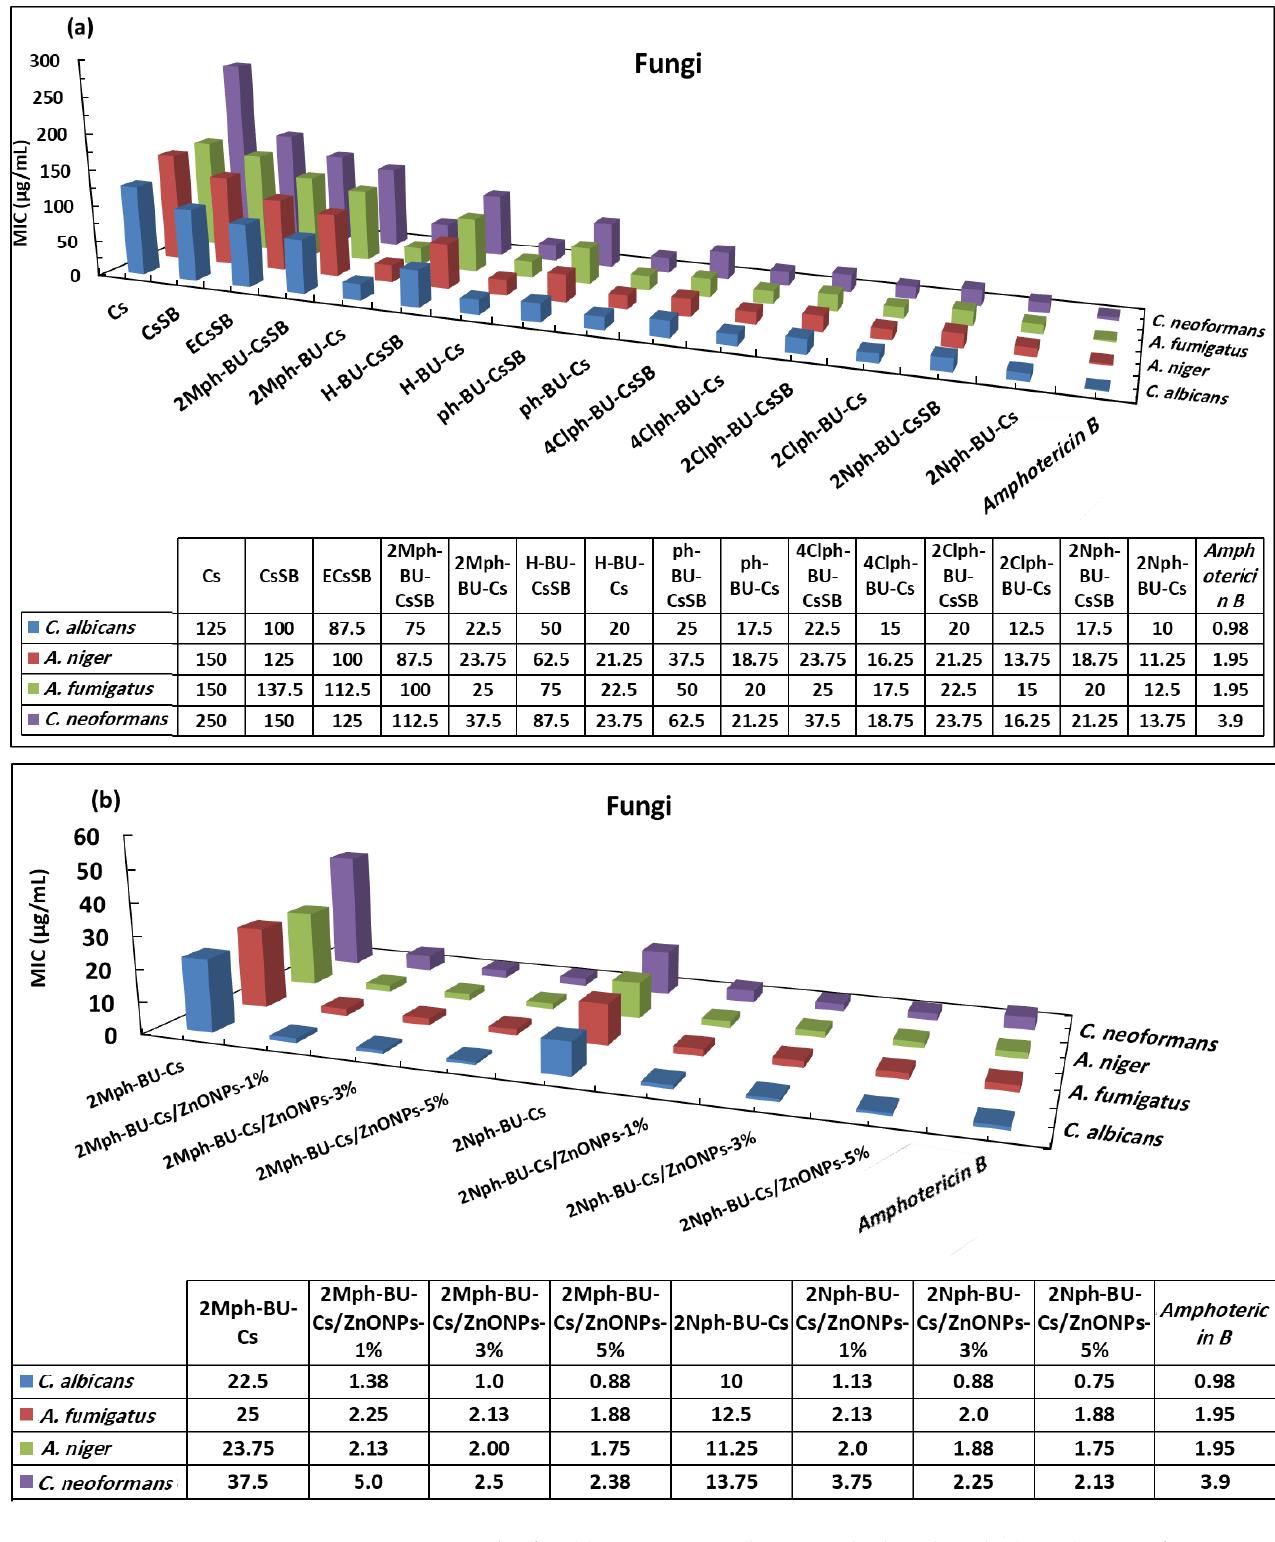
Figure 11. MIC index for: ( a ) R-BU-CsSB and R-BU-Cs hydrogels and ( b ) 2Nph-BU-Cs/ZnONPs and 2Mph-BU-Cs/ZnONPs composites against the inspected fungi. Again, all of the R-BU-Cs hydrogels showed a higher antifungal activity in comparison with their corresponding R-BU-CsSB hydrogels (Figure